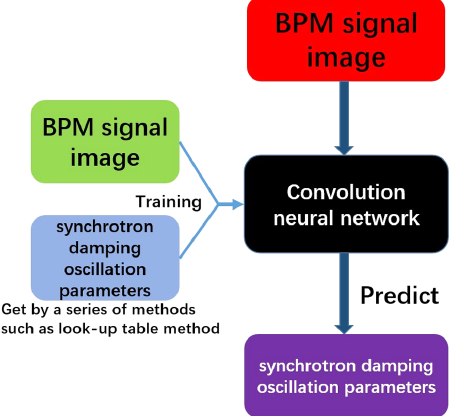
FIG. 4. Machine learning schematic to predict synchrotron damped oscillation parameters.